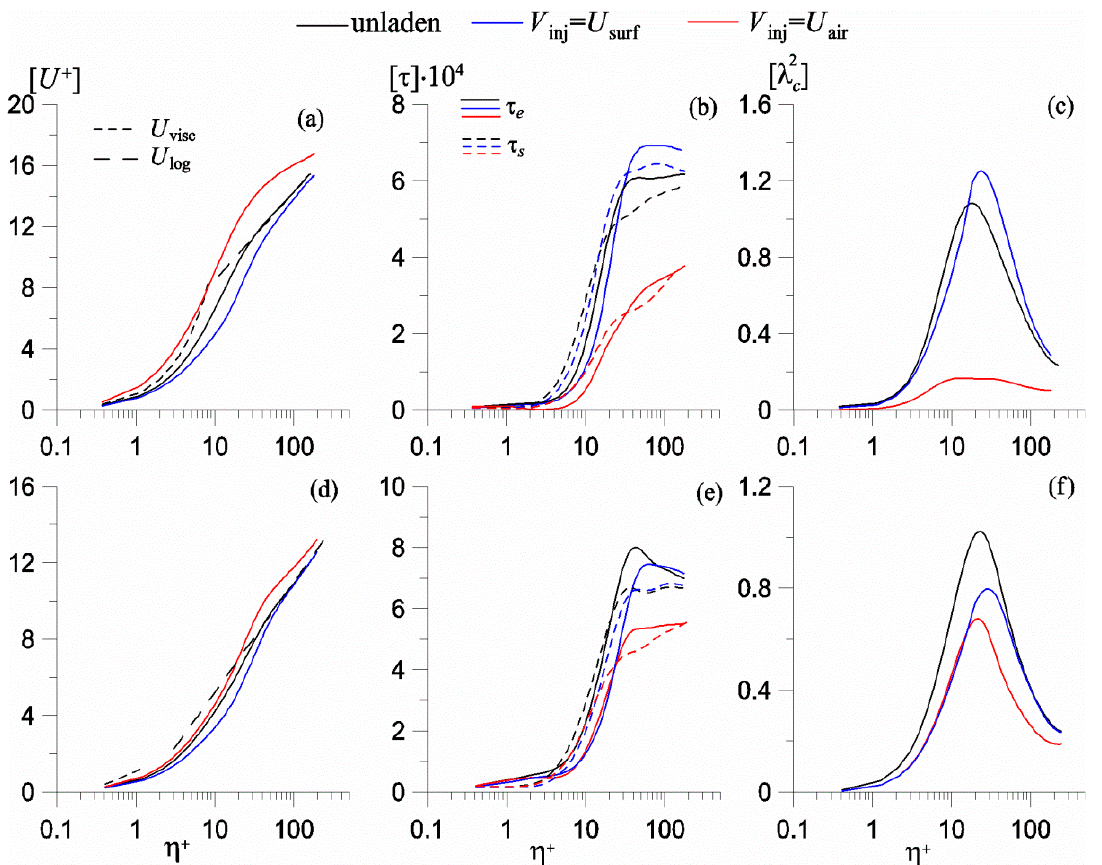
Figure 8. Profiles of mean velocity U + (panels a , d ), stresses [ τ e , s ] (full and dashed line, respectively) ( b , e ) and swirling strength ( c , f ) obtained for droplet-free (black) and laden flows ( V inj = U surf , blue, and V inj = U air , red) with wave steepness ka = 0.1 ( a – c ) and ka = 0.2 ( d – f ). The mean velocity profiles in panels ( a , d ) are compared against the viscous and logarithmic asymptotics, U visc and U log , Equation (34). η + = ην / u ∗ is the normalized distance to